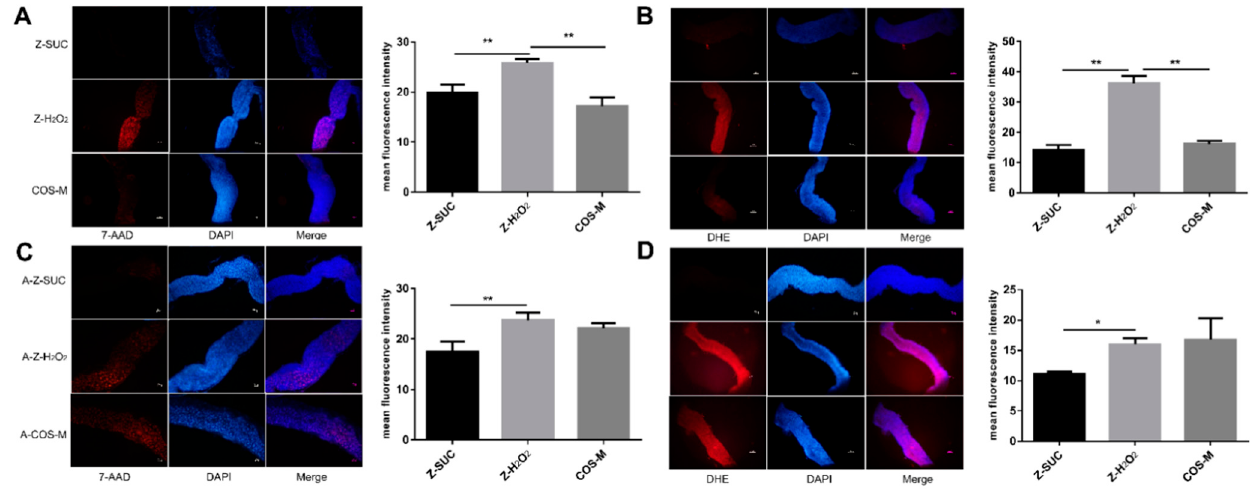
Figure 6. Gut dissected from female Drosophila ( A , C ) or axenic female Drosophila ( B , D ) with different treatments were stained with 7-AAD (red) and DHE (red) respectively. Nuclei were counterstained with DAPI (blue). Scale bar: 50 µ m. Differences among treatments were obtained with one-way analysis of variance followed by Tukey’s multiple comparisons test, * and ** represent p < 0.05 and p < 0.01 respectively.